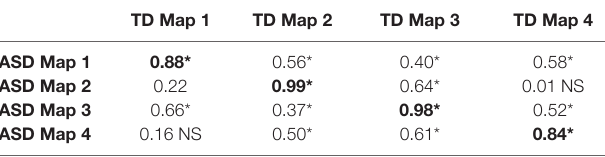
TABLE 1 | Pearson’s spatial correlation coefficients between autism spectrum disorder (ASD) and typically developing (TD) group map